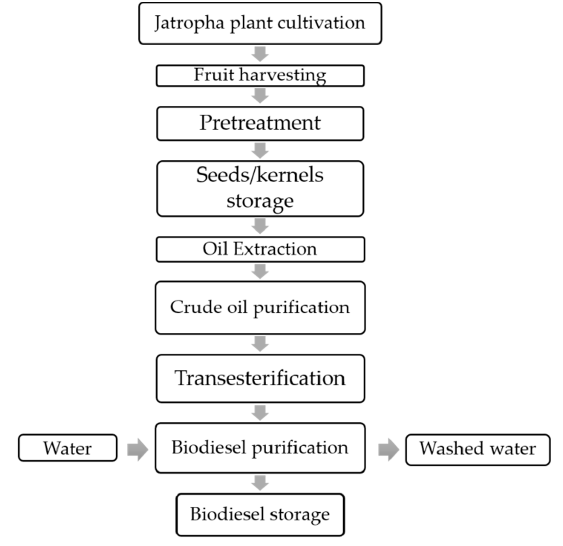
Figure 3. Biodiesel processing of Jatropha curcas [38–41].